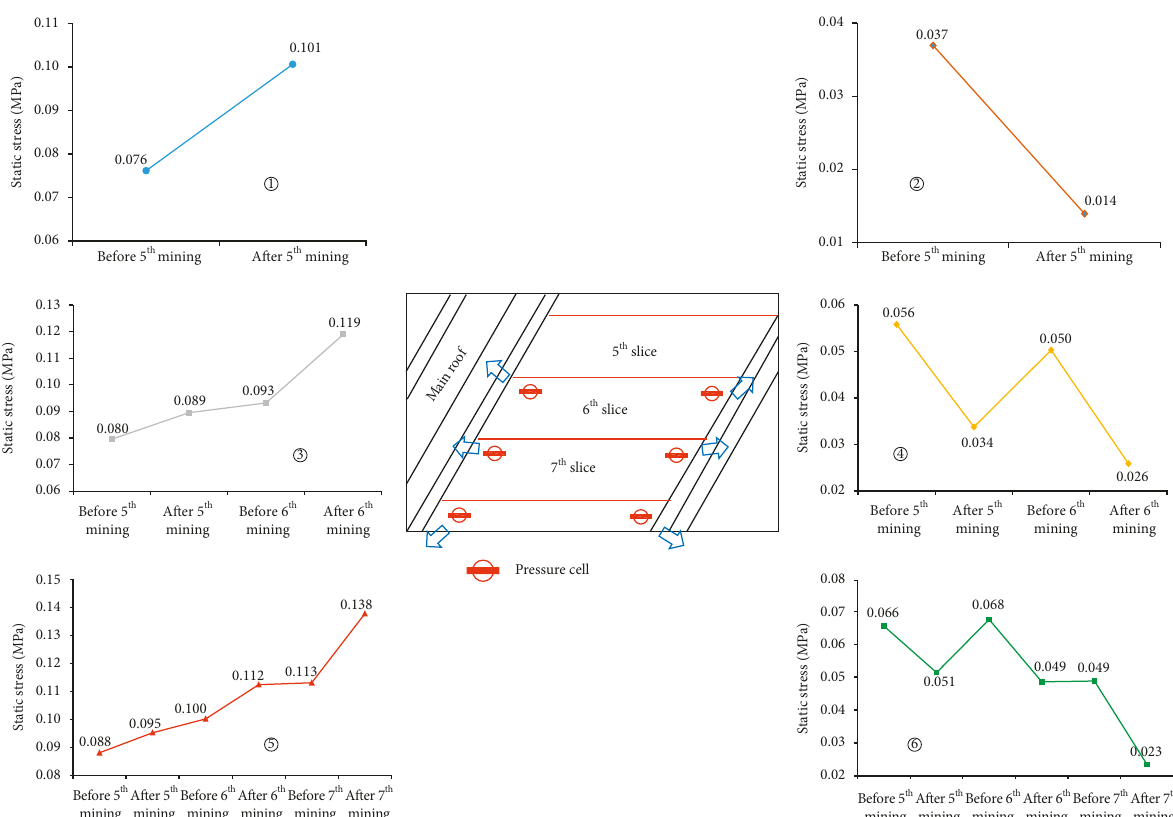
Figure 8: Monitoring results of static stress on roof and floor sides before and after slice